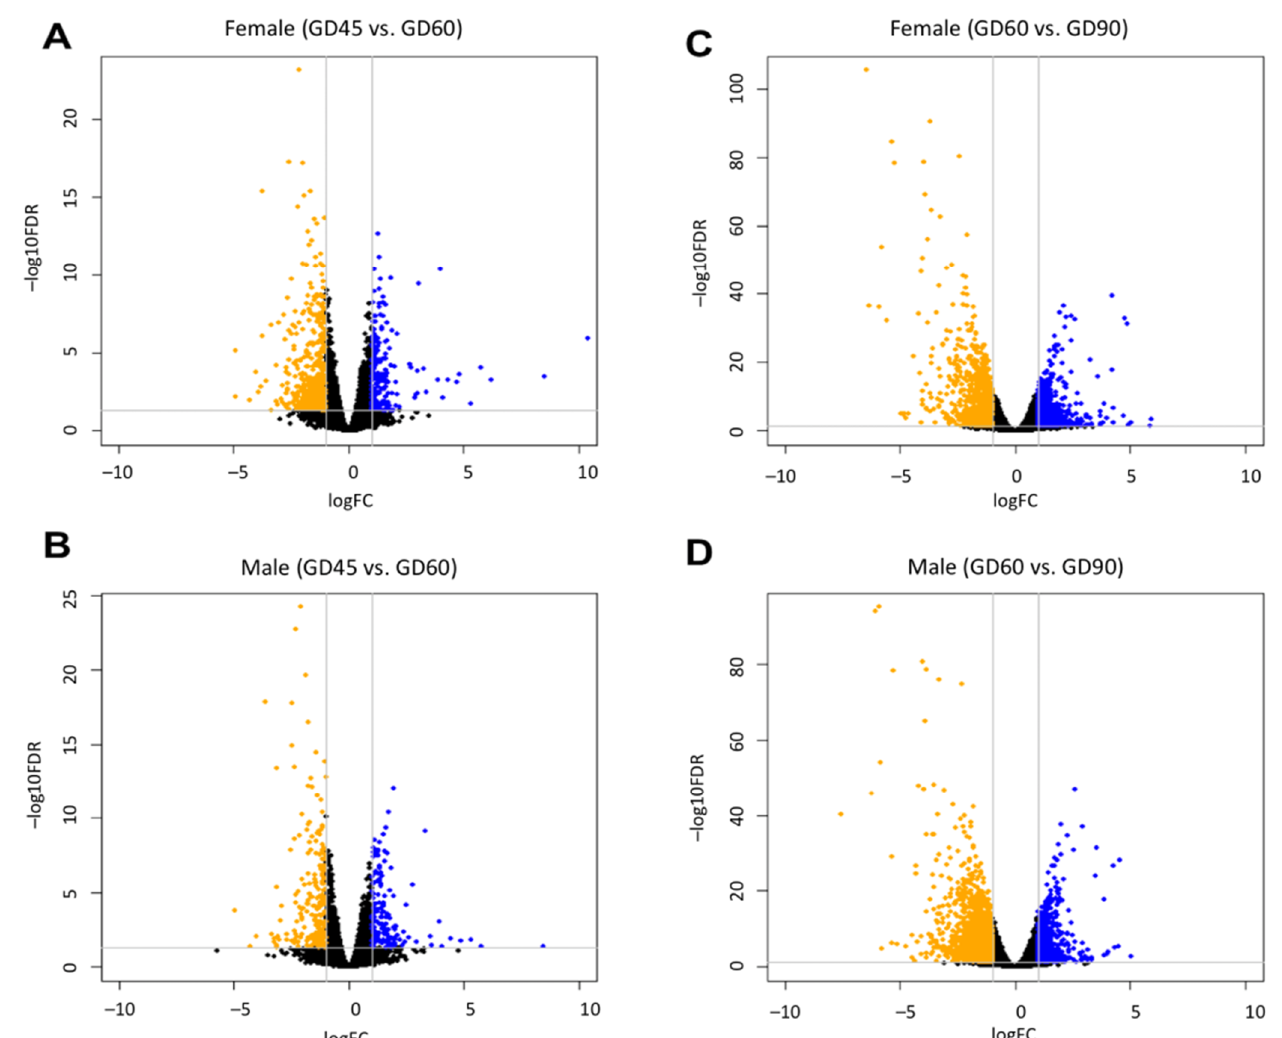
Figure 3. Volcano plots showing differential expression of genes in female fetal brain between GDs 45 vs. 60 ( A ), male fetal brain between GDs 45 vs. 60 ( B ), female fetal brain between GDs 60 vs. 90 ( C ), and male fetal brain between GDs 60 vs. 90 ( D ). In each plot, the y-axis shows the –log10(FDR) values and x-axis shows log fold change values. The orange color shows genes that are downregulated, and blue color shows genes that are upregulated between the two groups in each plot. The horizontal line above value 0 in y-axis represents FDR value of 0.05 used to identify significance of differential expression of genes. Table 1. Number of DEGs in developing male (M) and female (F) porcine fetal brains between GDs 45 vs. 60 and GDs 60 vs. 90. The direction of differential expression is also shown. Comparison Number of DEGs Differential Expression F.45 vs. F.60